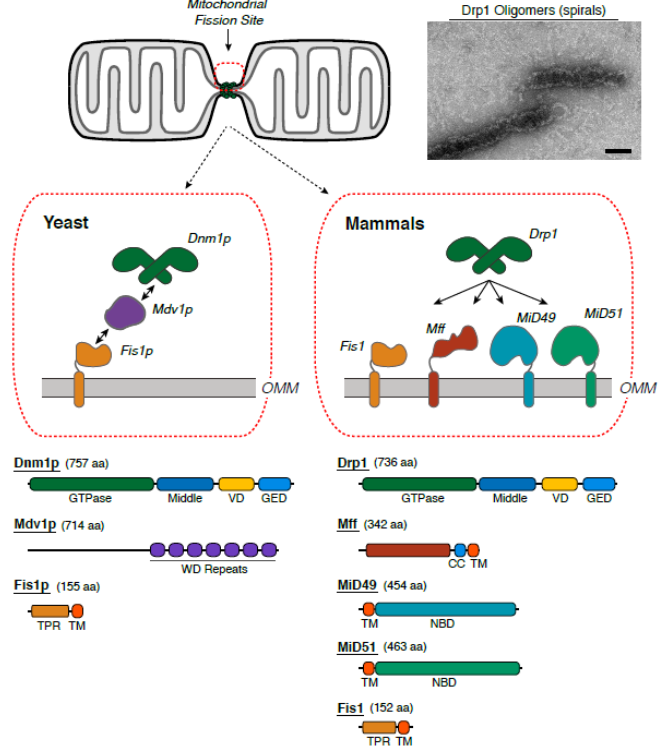
Figure 2. The molecular components of the mitochondrial fission machinery are presented. In yeast, mitochondrial fission is mediated by Dnm1p. Fis1p is anchored in the outer mitochondrial membrane (OMM), and Mdv1 is an adaptor for assembly of the multicomponent fission machinery. In mammals, Drp1 drives membrane fission. When a non-hydrolyzable guanosine-5’-triphosphate (GTP) analog ( βγ -Methyleneguanosine-5 ′ -triphosphate, or GMPPCP) is added to Drp1, it spontaneously forms oligomers that represent the contractile core of the fission apparatus. Several receptor proteins have been identified, including Fis1, Mff, MiD49, and MiD51. The primary sequence and protein domains are highlighted. Abbreviations: VD, variable domain; GED, GTPase effector domain; CC, coiled-coil domain; TM, transmembrane domain; NBD, nucleotide-binding domain; TPR, tetratricopeptide repeat; WD: repeating units containing a conserved core of approximately 40 amino acids that usually end with a tryptophan-aspartic acid dipeptide.